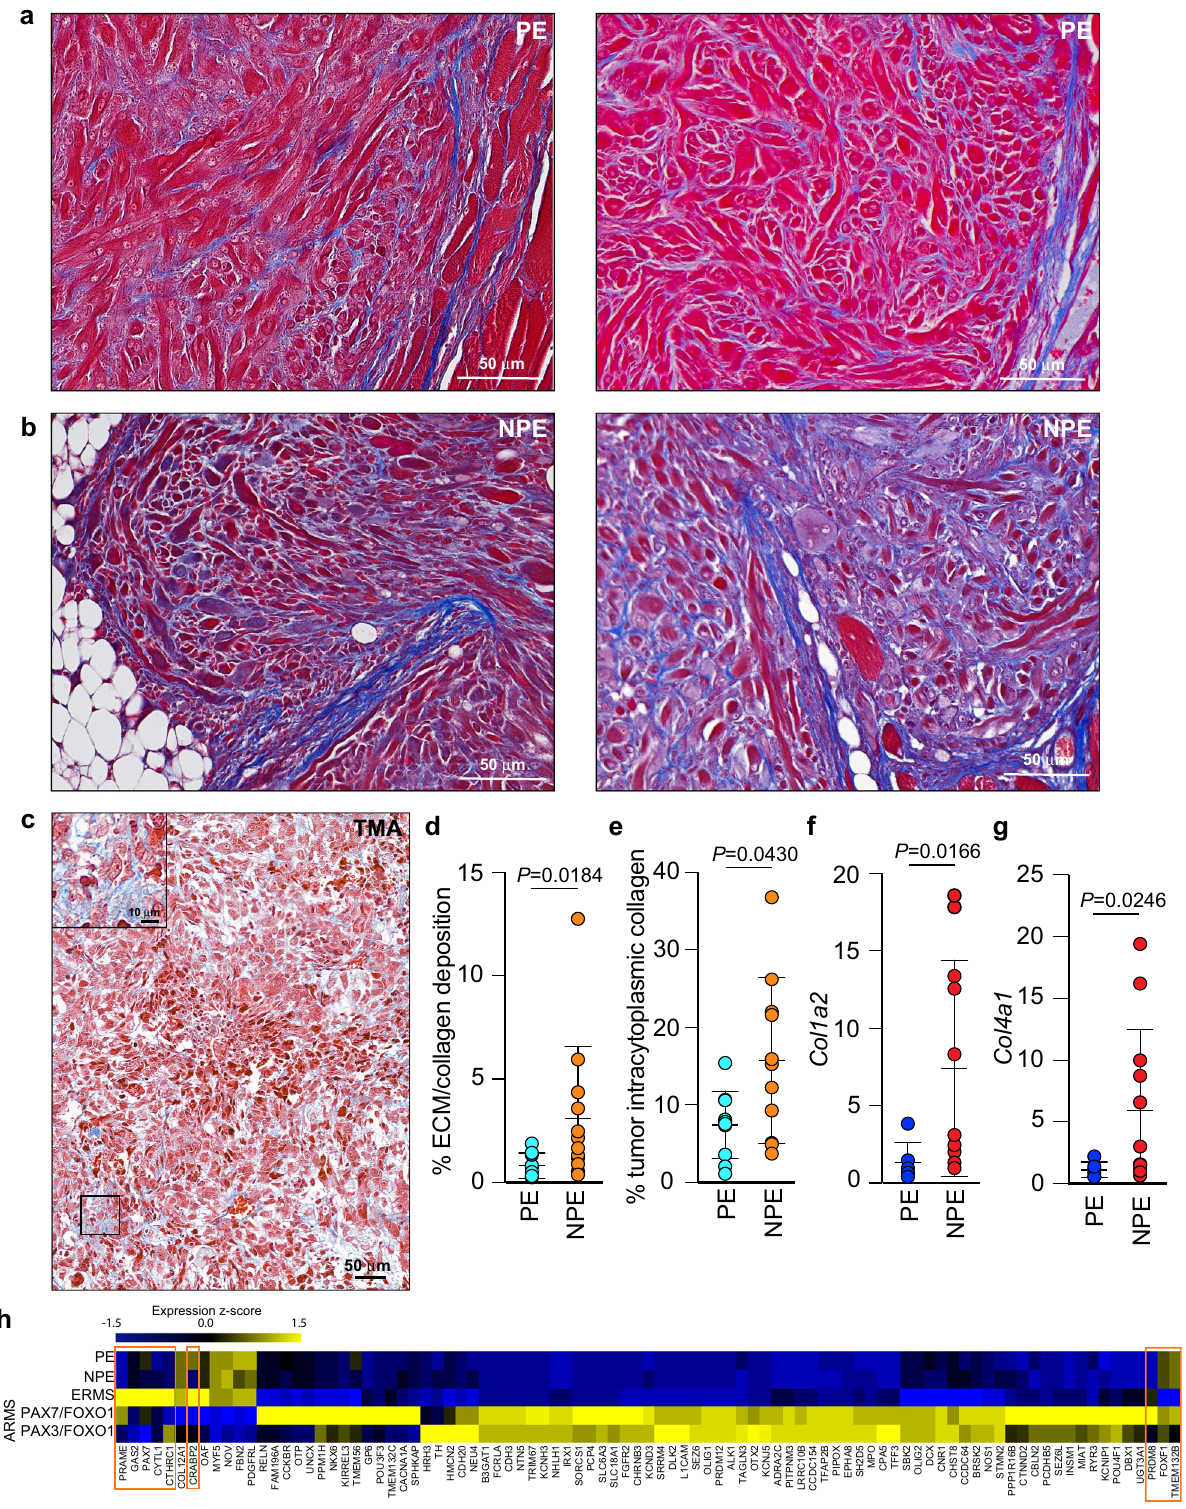
lysosomal exocytosis, and pleomorphism in limb and trunk NPE compared with PE RMS, we designed a multiplex high parameter fl ow cytometry strategy that evaluated Lamp1 PMpos cells sepa- rately from Lamp1 PMneg cells within three main cell populations: cancer, stroma, and hematopoietic cells (Fig. 4a). Protein expression data were generated by using Lamp1 PM in combina- tion with markers selective for each cell population 35,38 – 50